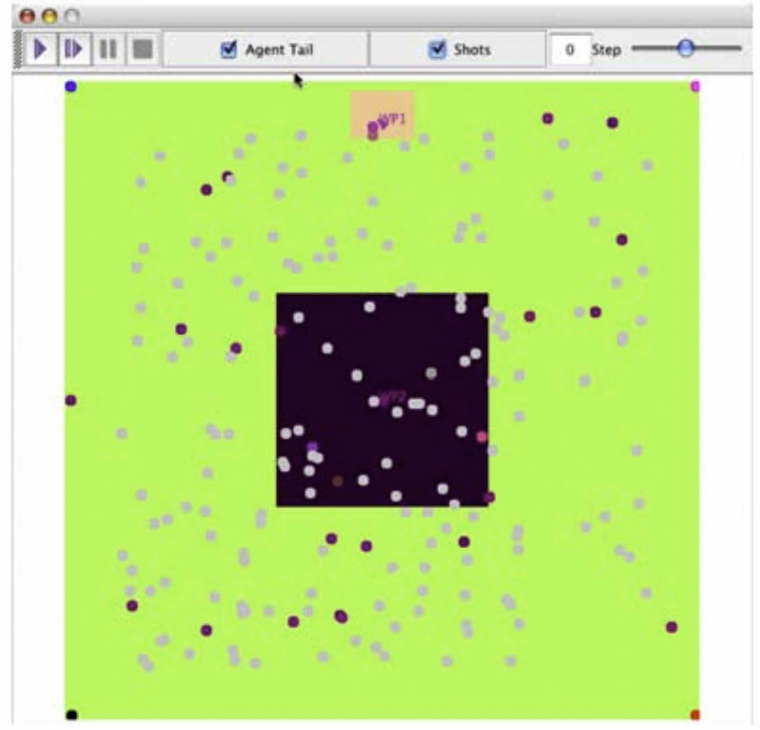
Figure 2. Spatial view the LostBoys scenario. Color definitions are in the text.